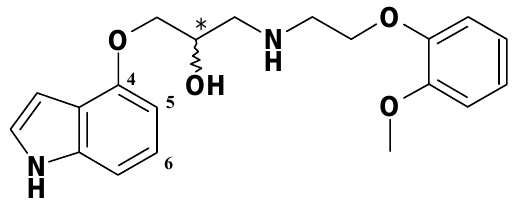
Figure 1. Chemical structure of the compound ( R,S )-9